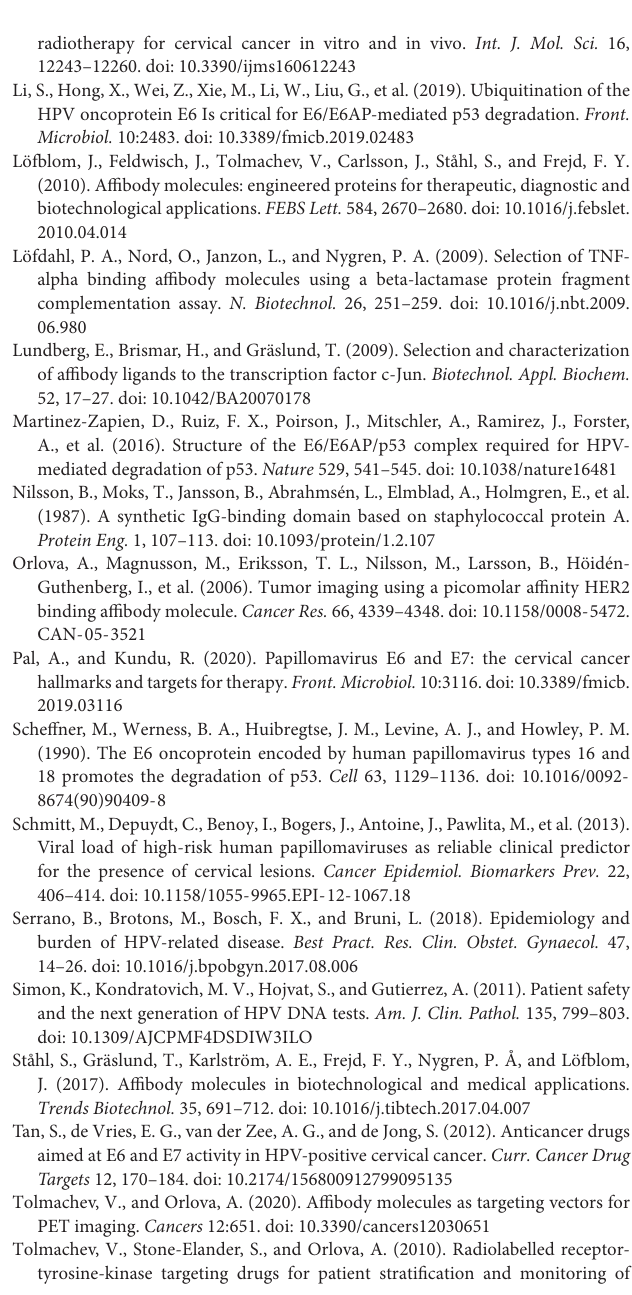
activity in ELISA. The 13 randomized amino acid positions are presented; dashes (–) indicate amino acids identical to those in the wild-type Z domain. The values on the right indicate the number of times each variant was detected out of 66 clones. Supplementary Figure 3 | In vivo biodistribution of affibody molecules in healthy normal mice. (A) The labeled affibody molecules were confirmed by SDS-PAGE and further detected at wavelengths of 730–950 nm by an in vivo fluorescence imaging system. (B,C) After tail vein injection with DyLight 755-labeled affibody molecules, fluorescence images were obtained from mice at different time points. Kidney uptake was prominent for the accumulation of affibody molecules. The accumulation of affibody molecules maximally occurred at 8 hpi and then decreased over the time course. The signal was undetectable at 72